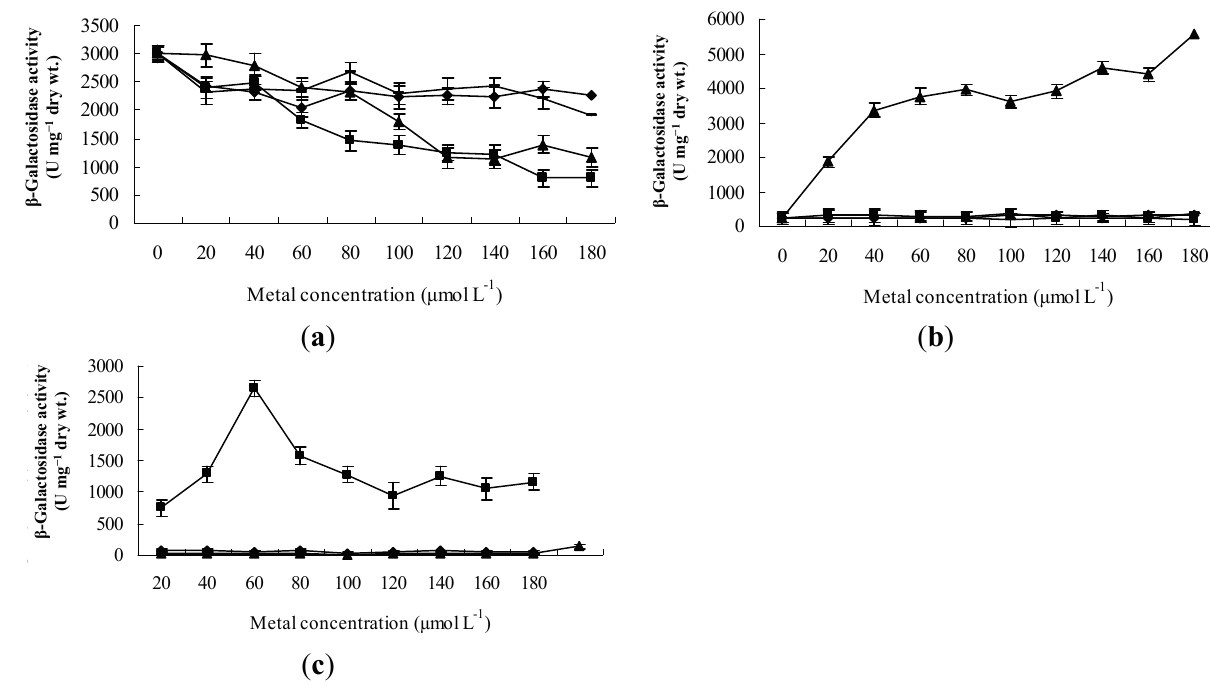
Figure 1. The expression patterns and inducer specificities of czcS1 , czcS2 , and czcH. LacZ activity were measured in permeabilized cells after induction with different concentrations of Cu 2+ ( ◆ ), Zn 2+ ( ■ ), Cd 2+ ( ▲ ), and Co 2+ (-) for four hours. Error bars represent the standard deviations of three determinations. ( a ) Response of the promoter czcRS1p to different metal ions; ( b ) Response of the promoter czcRS2p to different metal ions; and ( c ) Response of the promoter czcHp to different metal